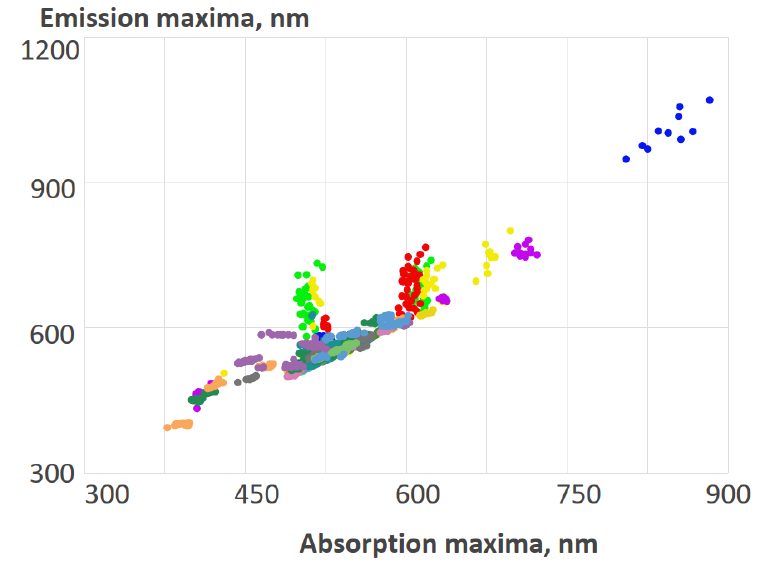
Figure 8. Absorption maxima versus emission maxima plot for a 24-cluster dataset of 115 BODIPYs. For the key for the clusters, see Figures 9 and 10.